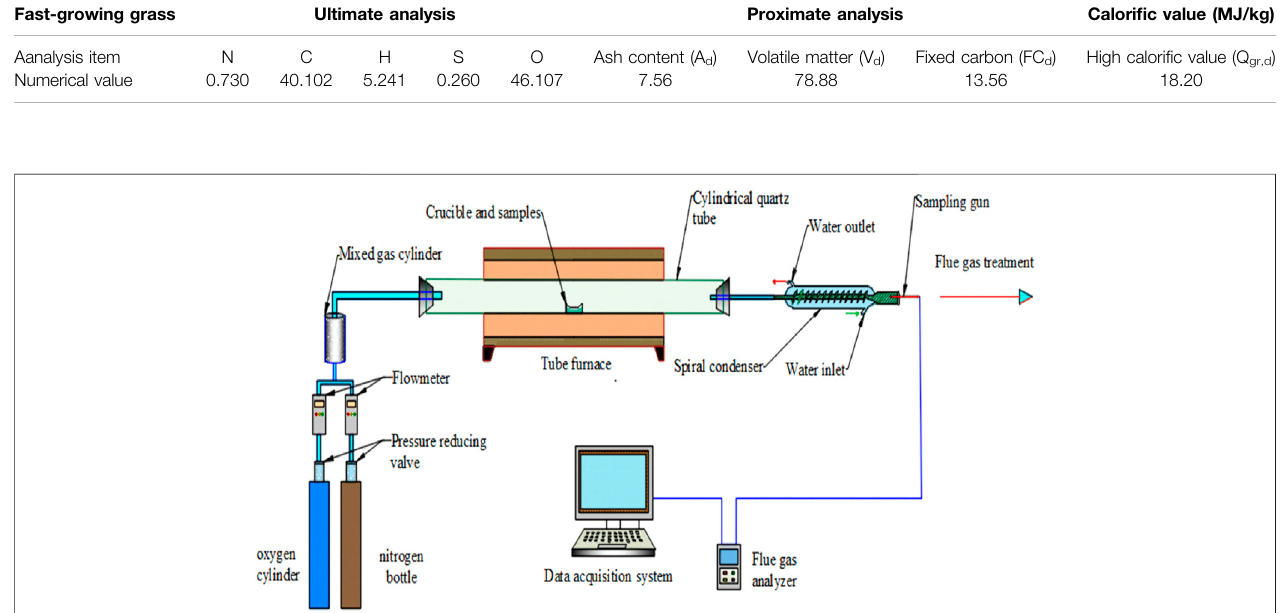
FIGURE 1 | Experimental system.